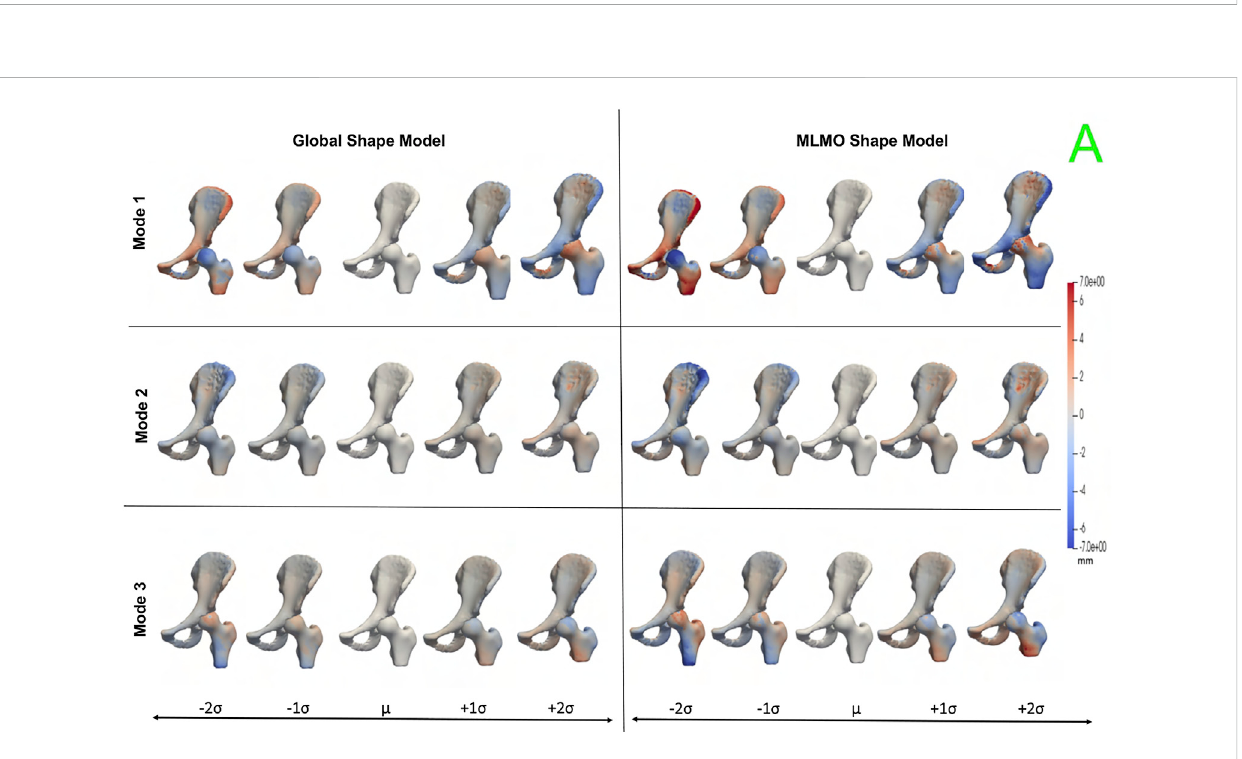
FIGURE 11 Within-organ modes of variation showing morphological changes in each bone for the hip joint dataset. The color map shows the distance of each mode from the mean